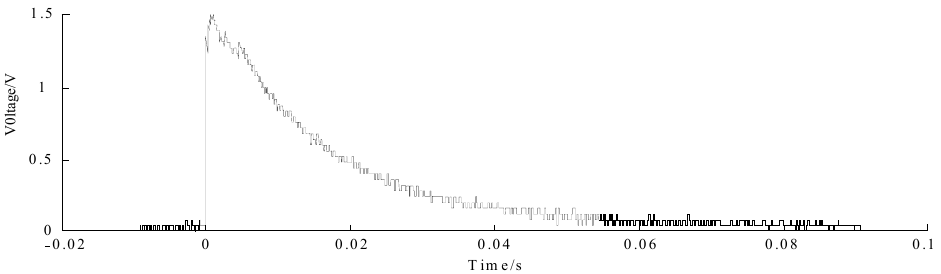
Figure 10. Corn kernel signal after filtering and envelope wave detection.